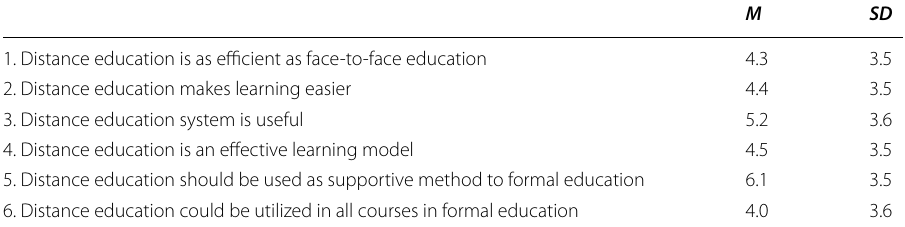
Table 7 Descriptive statistics of judgments regarding distance education